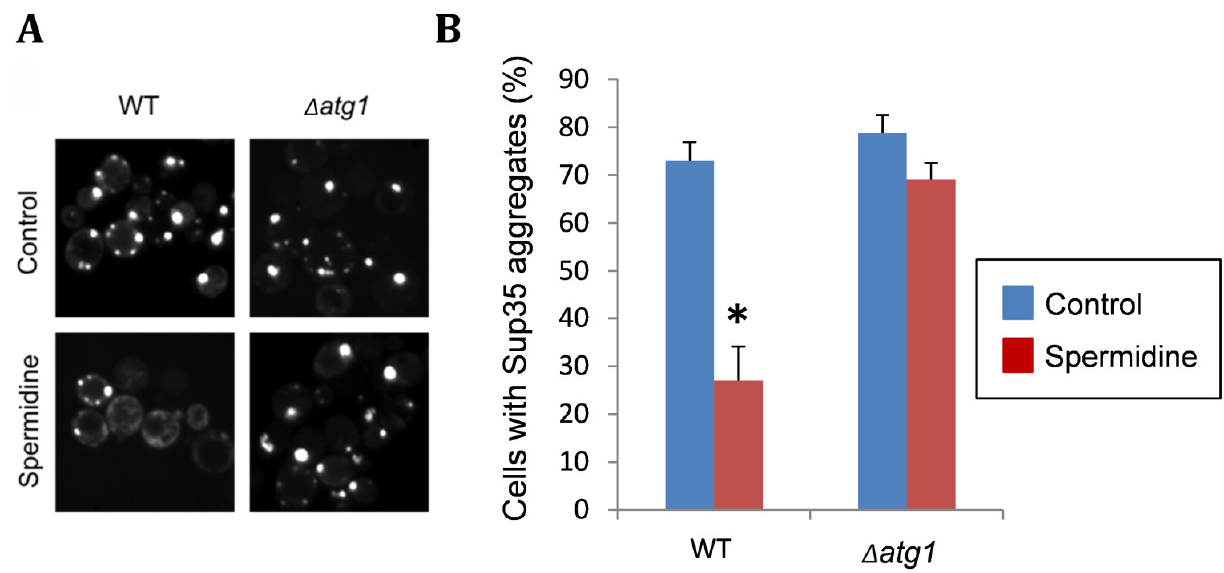
FIGURE 2: Spermidine treatment decreases the number of cells with visible Sup35 fluorescent aggregates. (A) Representative fluores- cence micrographs are shown for [ PIN + ][ PSI + ] versions of the wild-type yeast strain 74D-694 ( MATa ade1-14 ura3-52 leu2-3,112 trp1-289 his3-200) and an isogenic atg1 mutant containing the Sup35NM-GFP plasmid. Strains were grown in minimal media in the presence or ab- sence of 4 mM spermidine for 48 hours to induce autophagy. Sup35NM-GFP was induced with copper for one hour. Following copper induc- tion, fluorescent foci can be detected due to the coalescence of newly made Sup35NM-GFP with pre-existing Sup35 aggregates. (B) The percentage of cells containing visible puncta is shown for each strain from an average of 300 cells counted. Data shown are the means of three independent biological repeat experiments ± SD. The number of visible aggregates in the wild-type strain treated with spermidine is significantly different to the number of aggregates detected in the same strain in the absence of spermidine (* p =